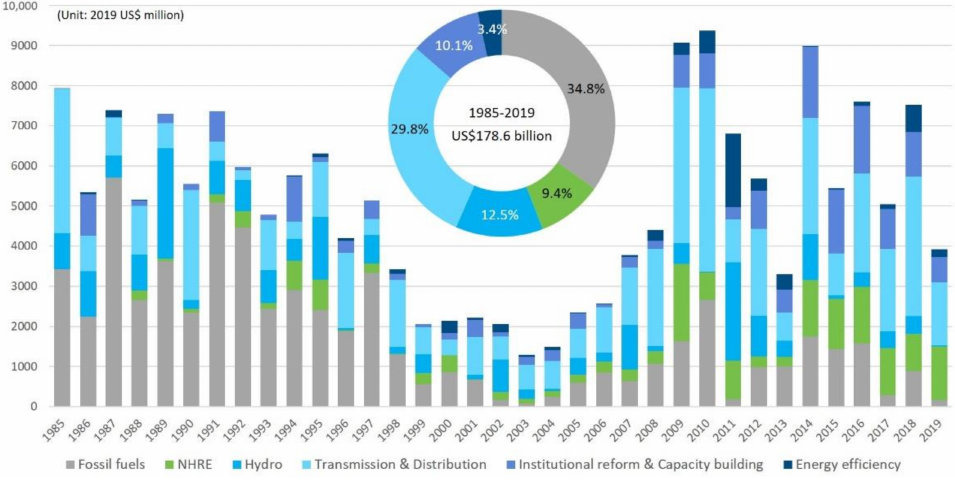
Figure 7. Sector-specific energy finance (1985–2019). Source: authors’ illustration based on